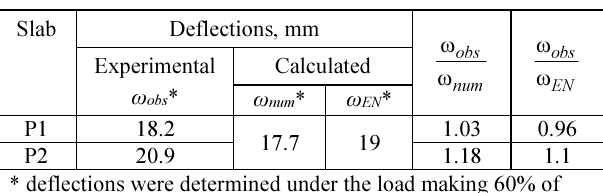
Table 4. Comparison of research on slab deflections